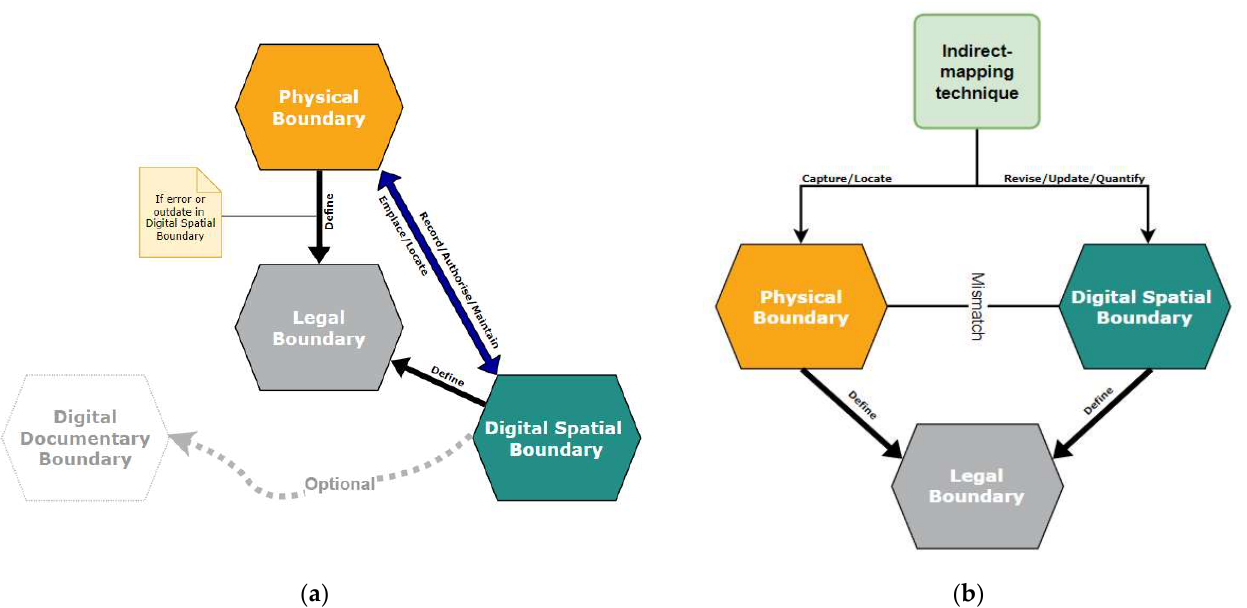
Figure 13. Land boundaries and inconsistencies based on cadastral triangular model (CTM) for digital indirect-mapping techniques; ( a ) CTM for Fit-for-purpose and countries with no or low cadastral coverage; ( b ) Fit-for-purpose maintenance for countries with complete cadastre based on indirect-mapping techniques and CTM.